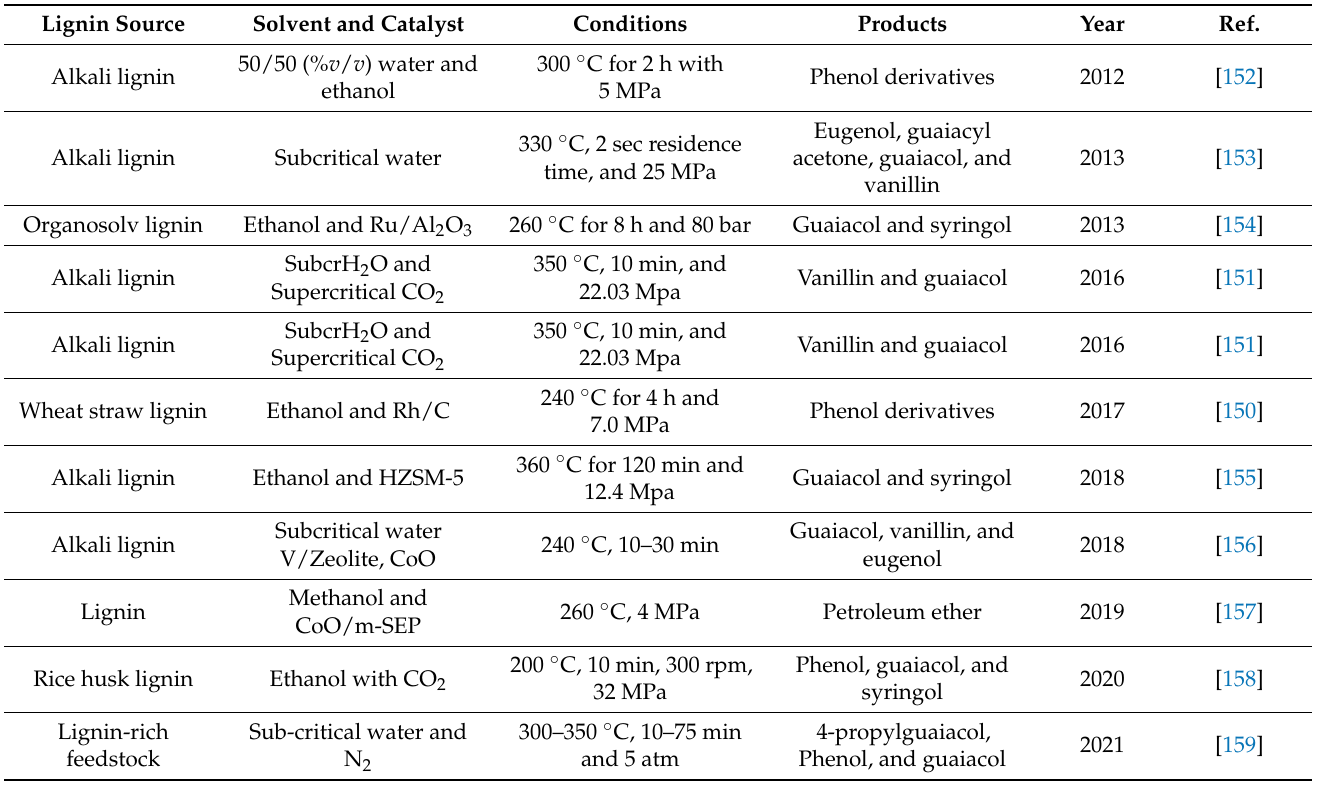
Table 7. Sub- and supercritical depolymerization of